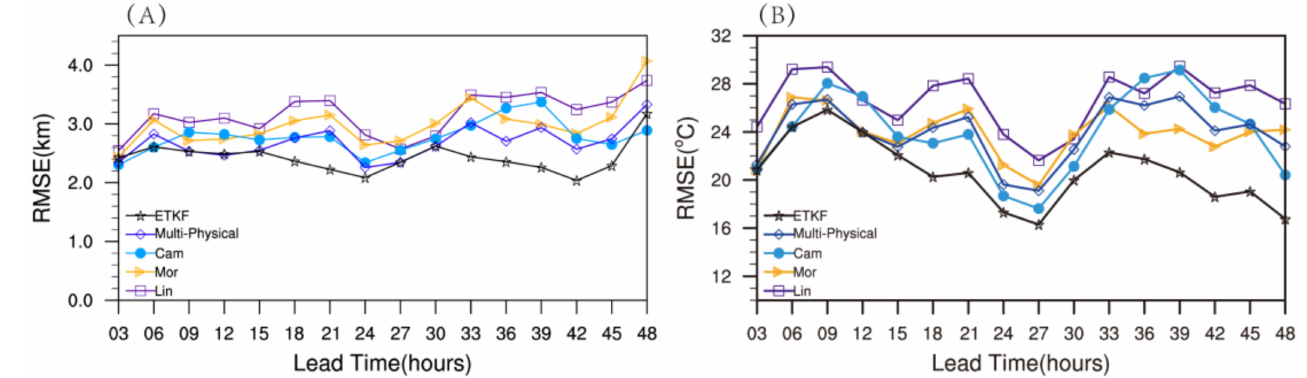
Figure 3. RMSE sequence of the ( A ) cloud-top height and ( B ) temperature simulated by three schemes and two ensemble methods.